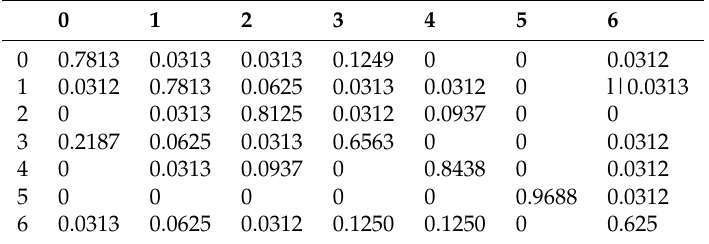
Table 9. Classification confusion matrix (ratio) for DataSet1 by using